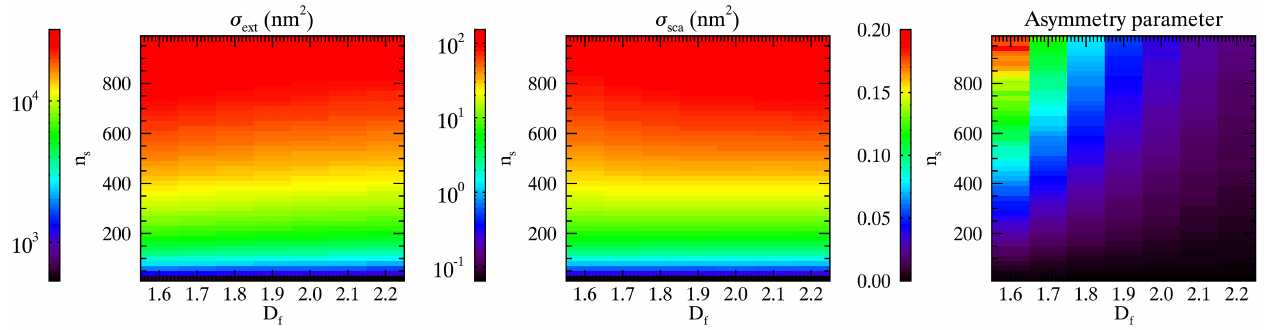
Figure 6. Extinction cross section, scattering cross section, and asymmetry parameter calculated using the MSTM code at λ = 12µm for a range of fractal dimensions and numbers of spherules.